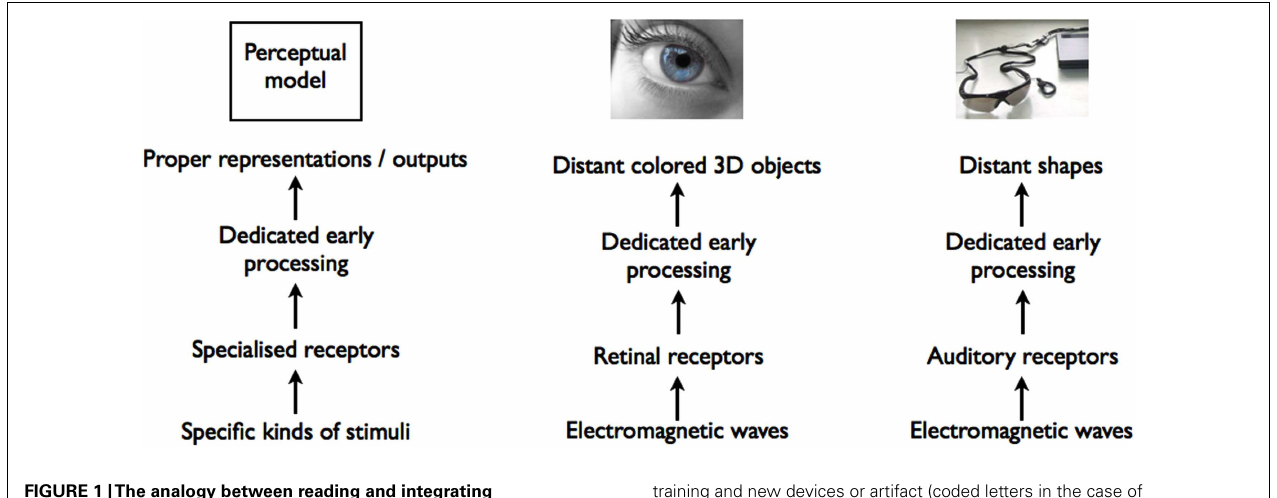
FIGURE 1 |The analogy between reading and integrating visual-to-auditory sensory substitution devices (like the vOICe). Full arrows indicate new elements brought about by